Question: Produce a descriptive caption suitable for publication.
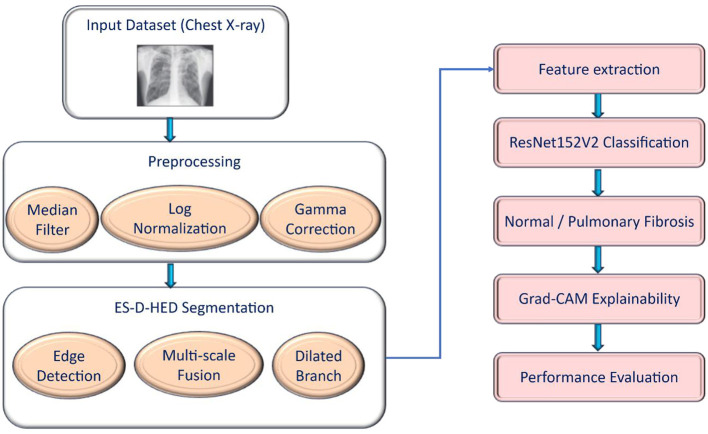
Answer: Comparison of existing lung segmentation and classification approaches.